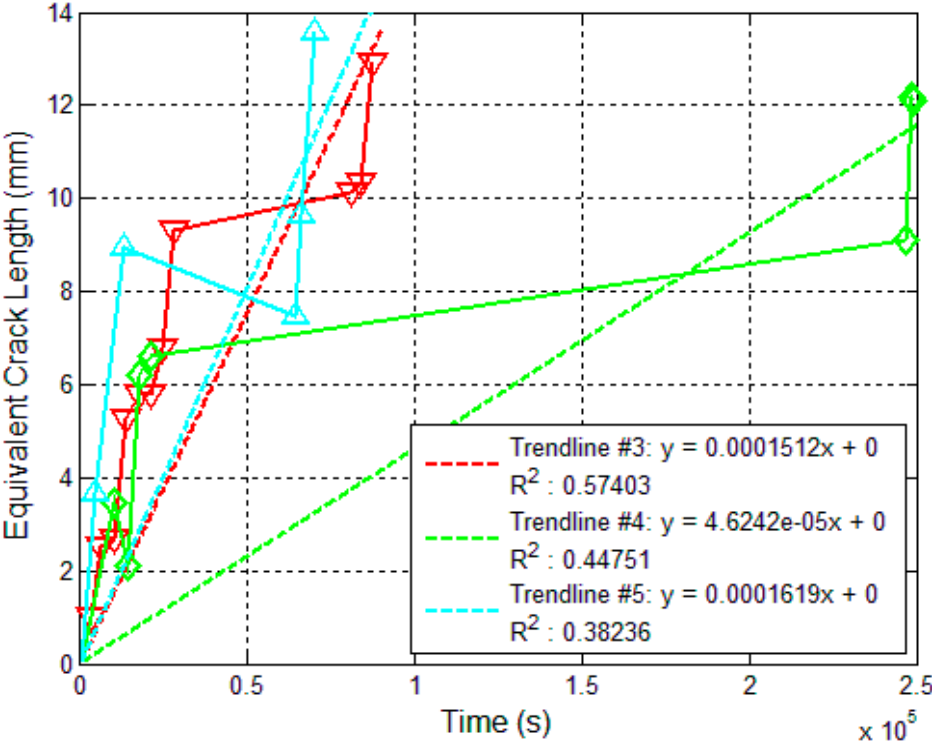
Figure 6. Equivalent crack length versus time curves related to creep loading levels of 75 and 80%.